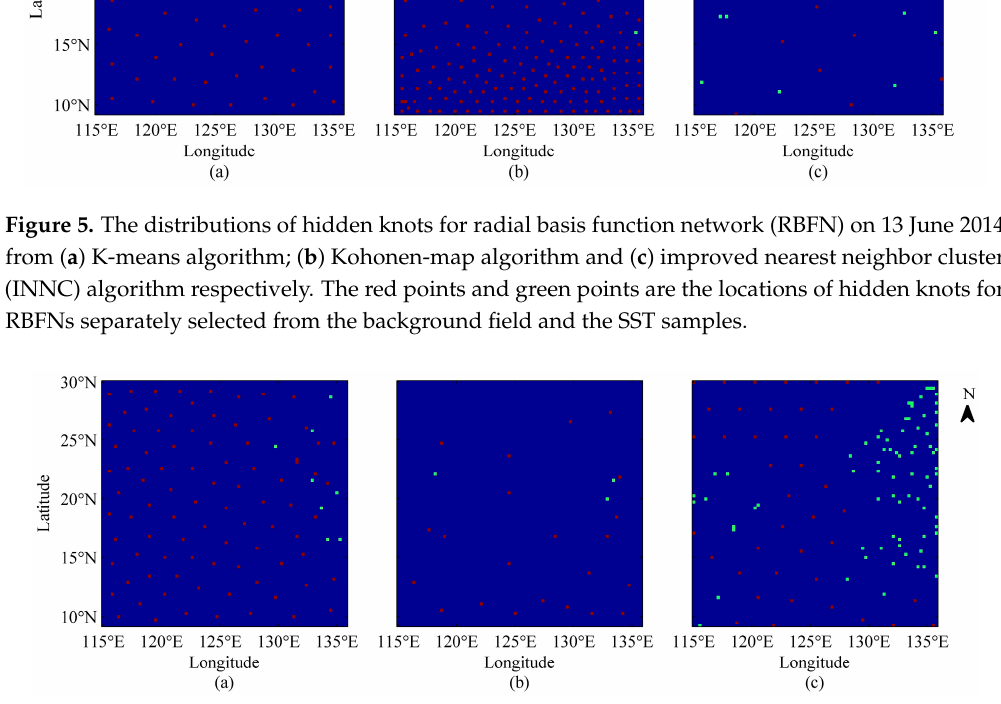
Figure 6. The distributions of hidden knots for RBFN on 18 June 2014 from ( a ) K-means algorithm; ( b ) Kohonen-map algorithm and ( c ) INNC algorithm respectively. The red points and green points are the locations of hidden knots for RBFNs separately selected from the background field and the SST samples.